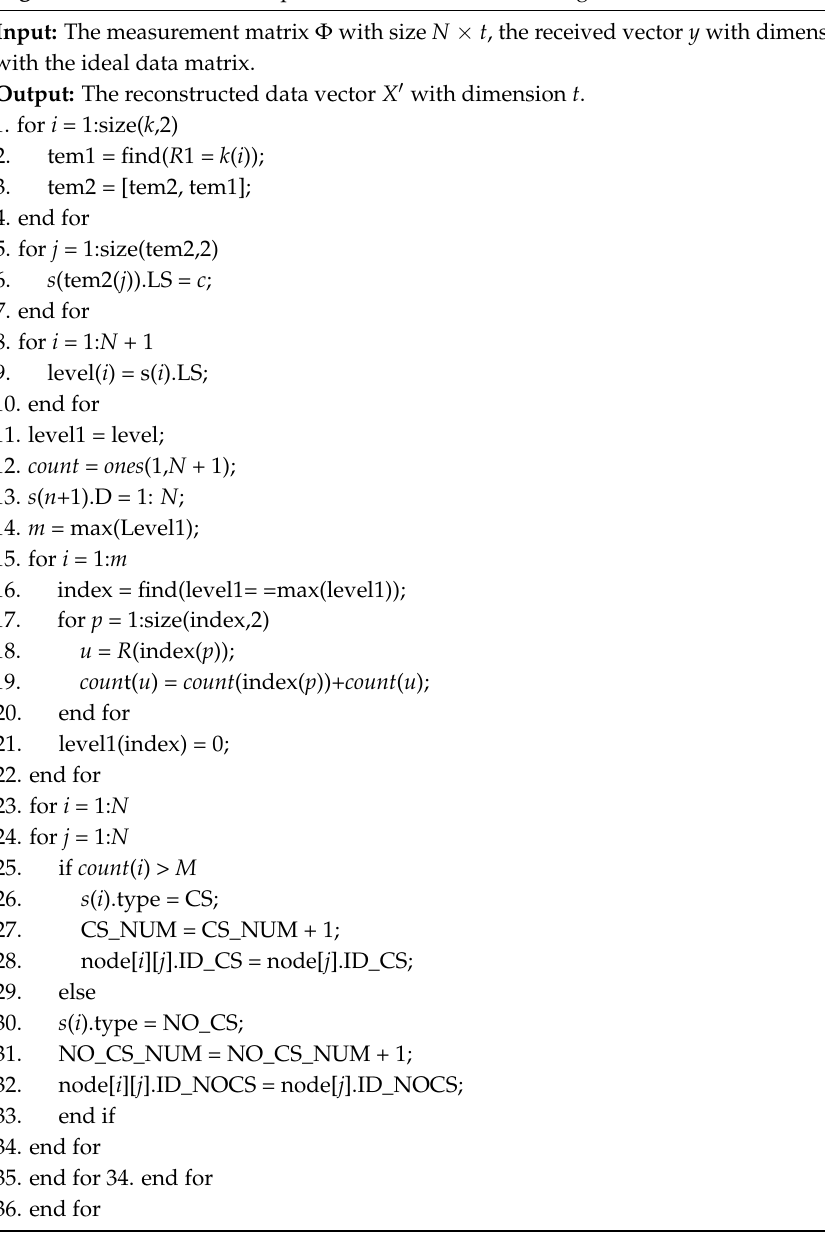
Algorithm 1 The detailed step of the data reconstruction